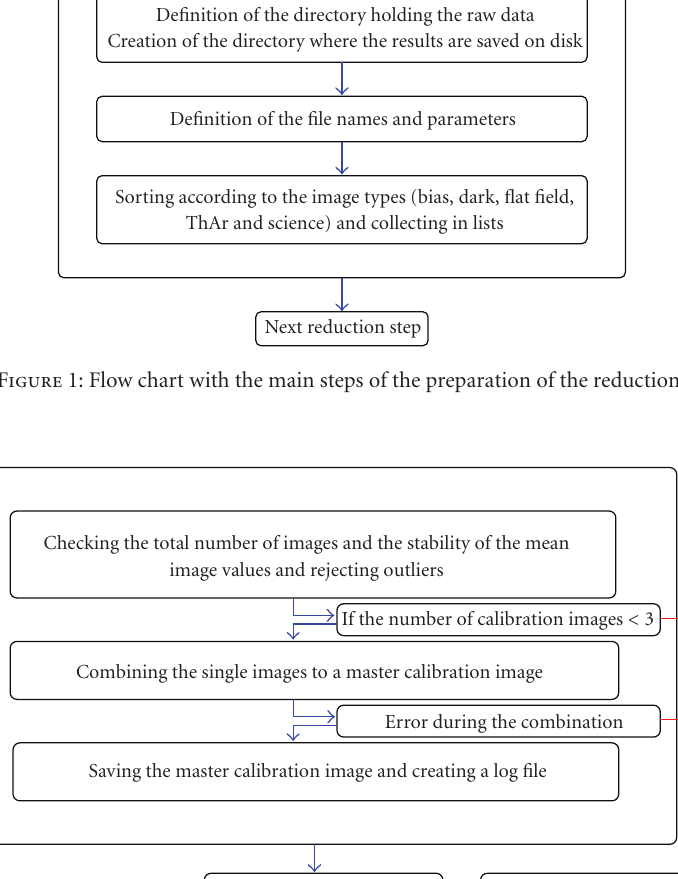
dark, and flat field. The flow chart in Figure 2 shows the main steps in this